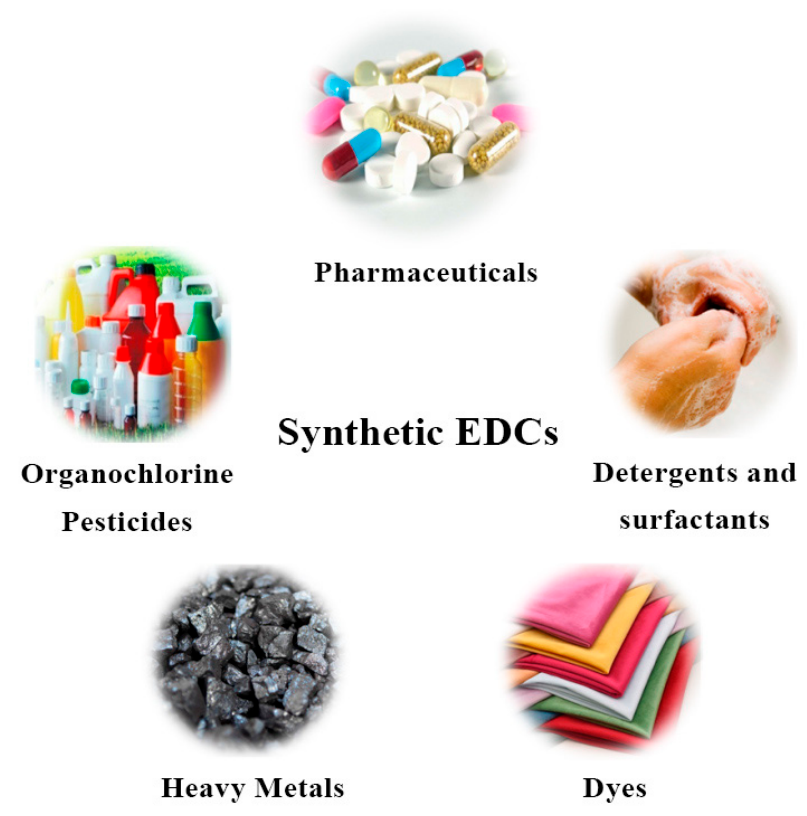
Figure 1. Different sources of synthetic EDCs.